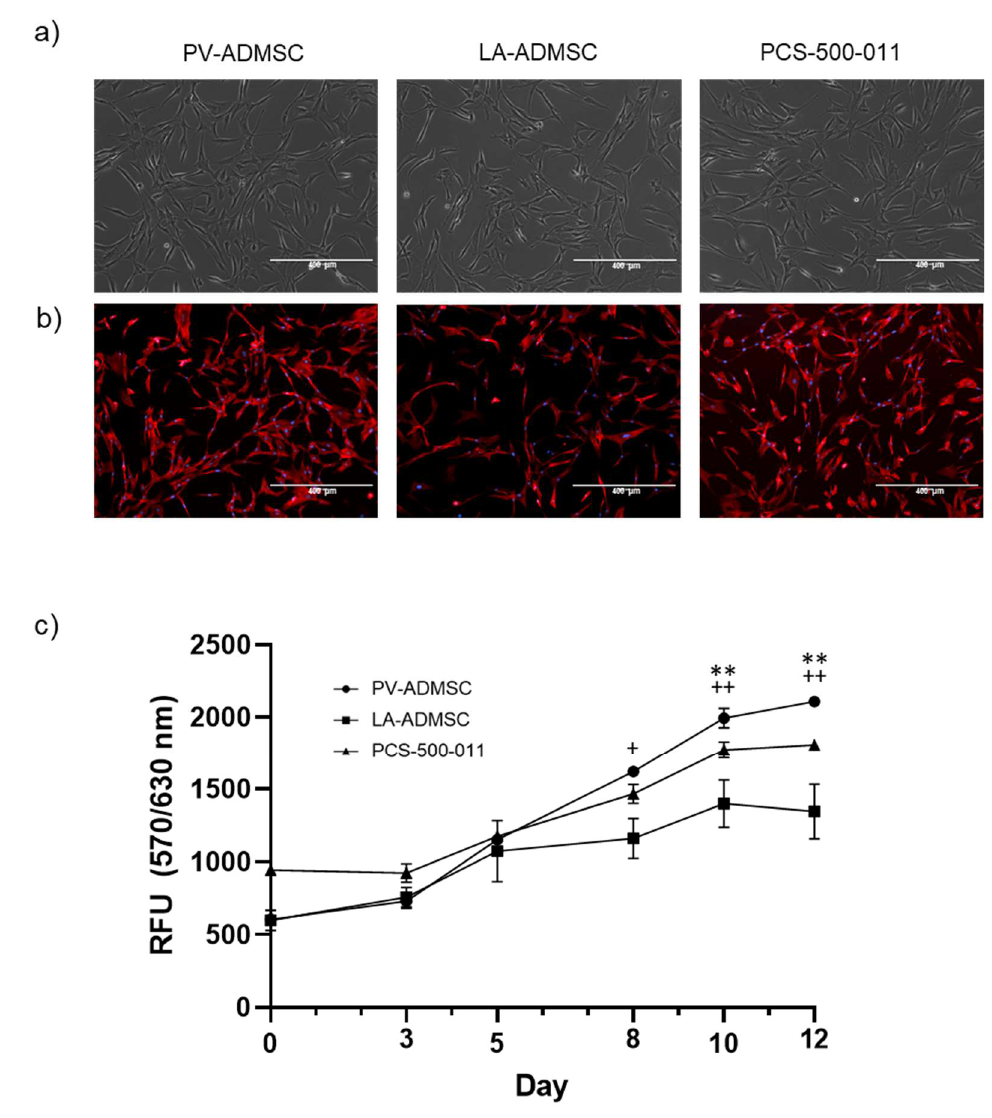
Figure 1. Morphology and growth characteristics of ADMSCs obtained from different sources. ( a ) Characteristic phase contrast microscopy in passage 3 (bar: 400 µm); ( b ) fluorescent staining of actin filaments in passage 3, nuclei were counterstained with DAPI (bar: 400 µm); ( c ) metabolic activity assessment using Alamar Blue (resazurin) assay. Differences between PV and PCS: ** p < 0.01; differences between PV and LA: + p < 0.05, ++ p < 0.01 were calculated using ANOVA.